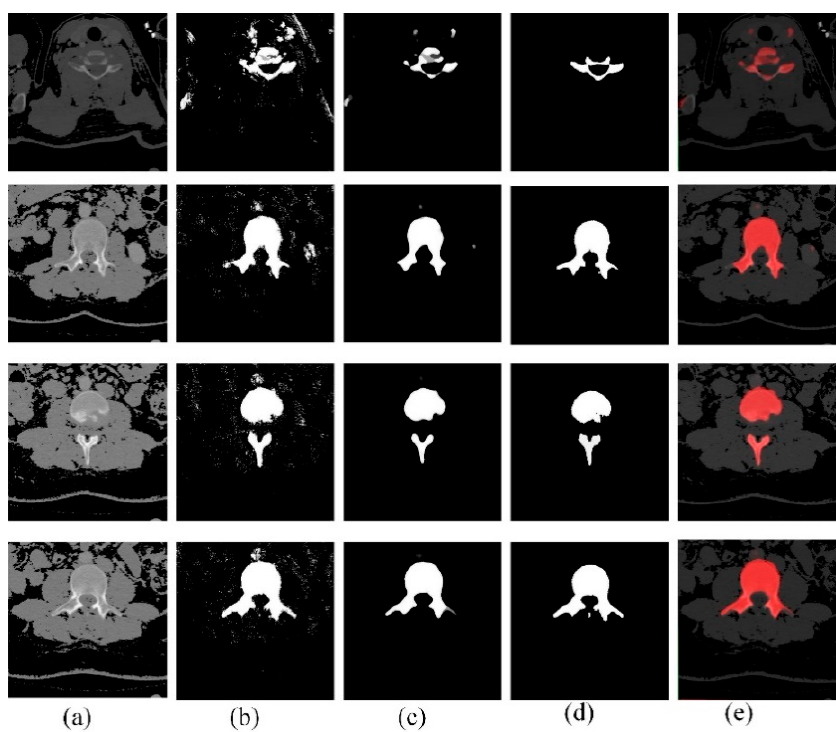
Figure 8. Segmentation results from randomly selected axial slices of test CT image 1: ( a ) raw image; ( b ) initial segmentation; ( c ) finial segmentation; ( d ) ground truth; and ( e ) segmentation superimposed on CT image.